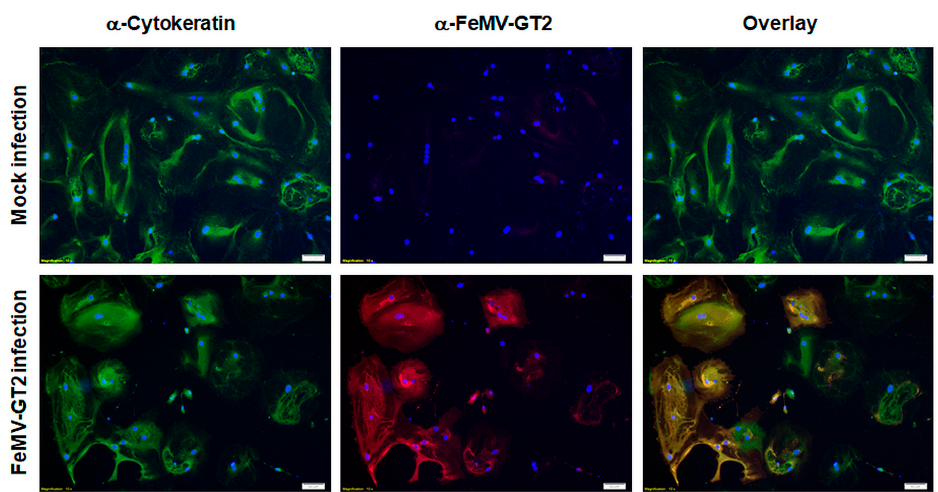
Figure 7. Susceptibility of feline pulmonary epithelial cells to FeMV-GT2. Primary feline pulmonary epithelial cells were inoculated with FeMV-GT2-Gordon strain at an MOI of 0.5 or mock-infected. Cells were fixed five days p.i. and stained for cytokeratin (shown in green) or FeMV-GT2 (shown in red). Double positive cells are shown in orange. Cell nuclei were visualized with DAPI (shown in blue). Images were taken at 100-fold magnification. Scale bar represents 50 µm.